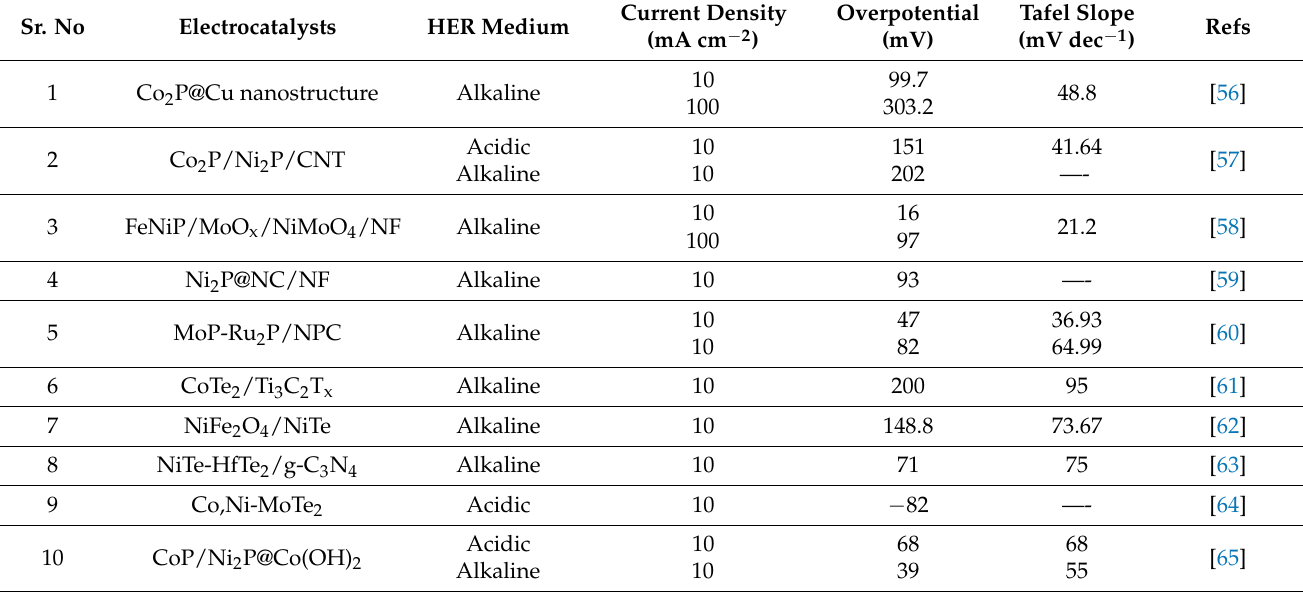
Table 1. Performance of TMP- and TMT-based electrocatalysts for hydrogen evolution reaction (HER). Sr.